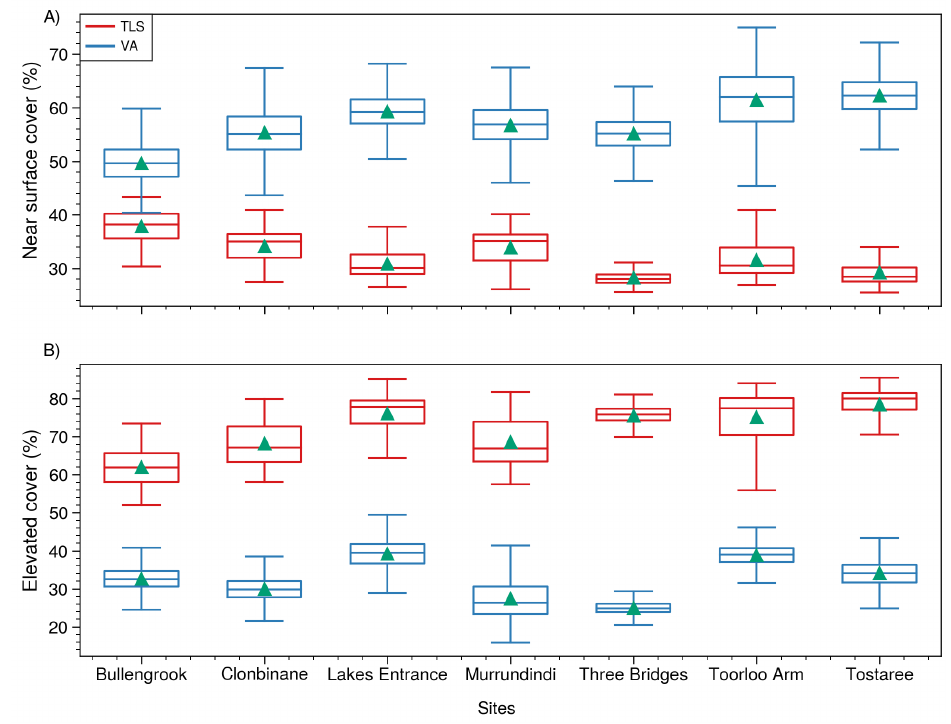
Figure 6. Box plots showing comparison between mean prediction of cover (%) from the random forest models trained with TLS observations and mean prediction from the random forest models trained with visual assessments for ( A ) near-surface and ( B ) elevated